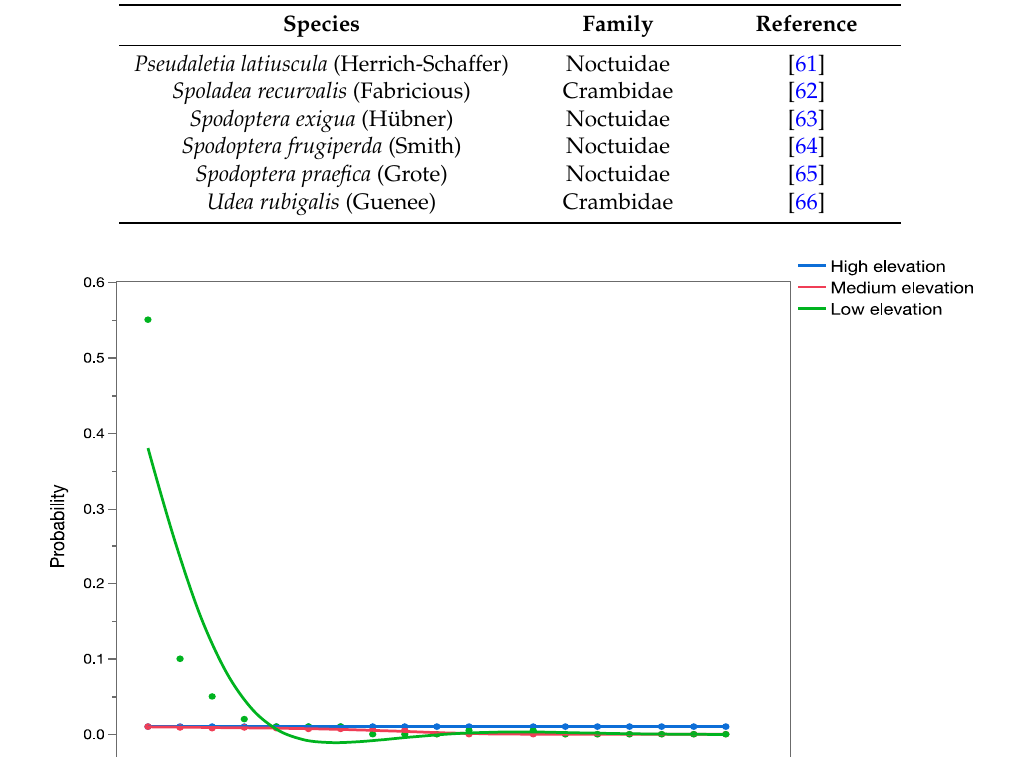
Figure 3. Overlay chart showing forecast of expected parasitism rates (proportion on x -axis) for C. marginiventris at low-, medium-, and high-elevation sites using early published data [Table 6]. Table 6. List of hosts of C. marginiventris in its native range known prior to its introduction to Hawaii in 1942.